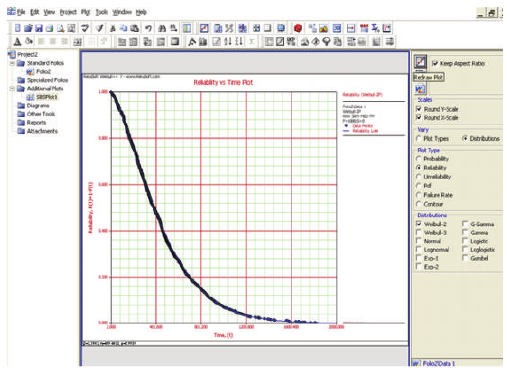
Figure 7: Reliability